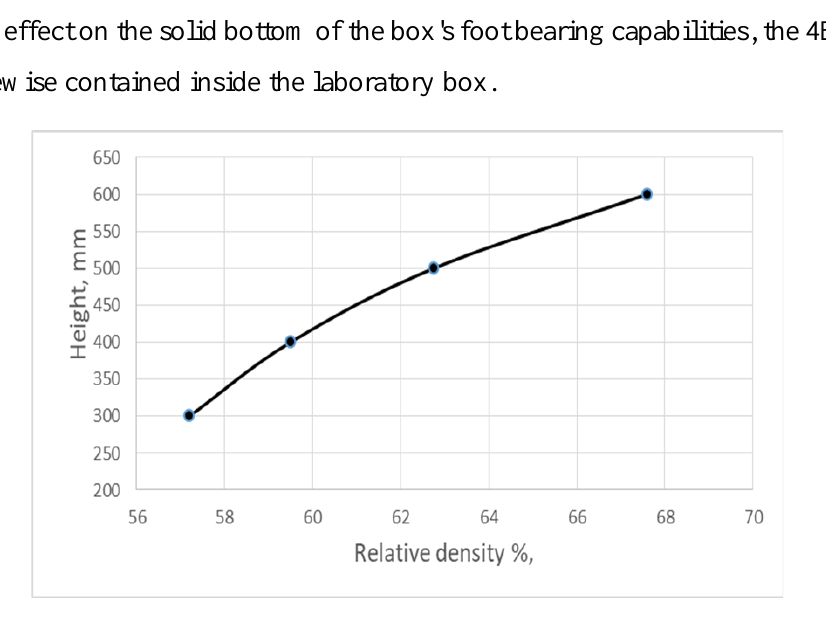
Fig. 3. Height versus relative